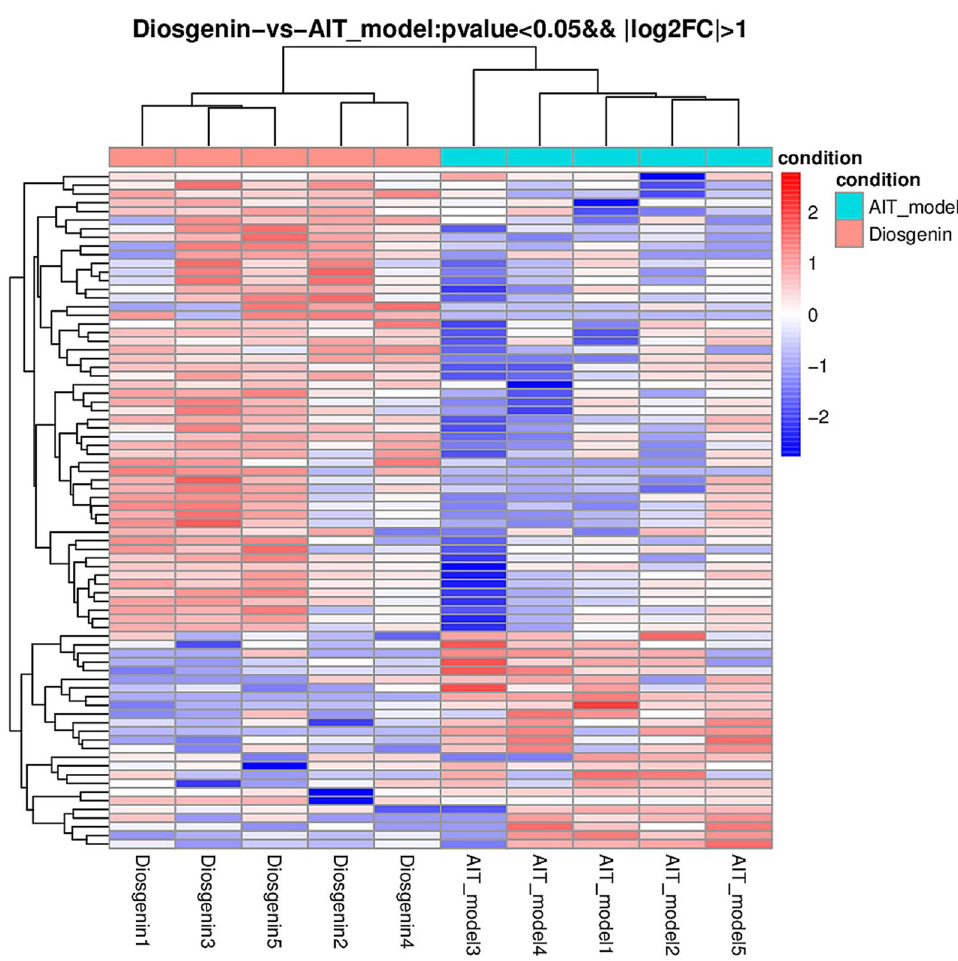
Figure 3. Cluster analysis results of different groups. Caption: In the picture, red indicates highly expressed genes, and blue indicates lowly expressed protein-coding